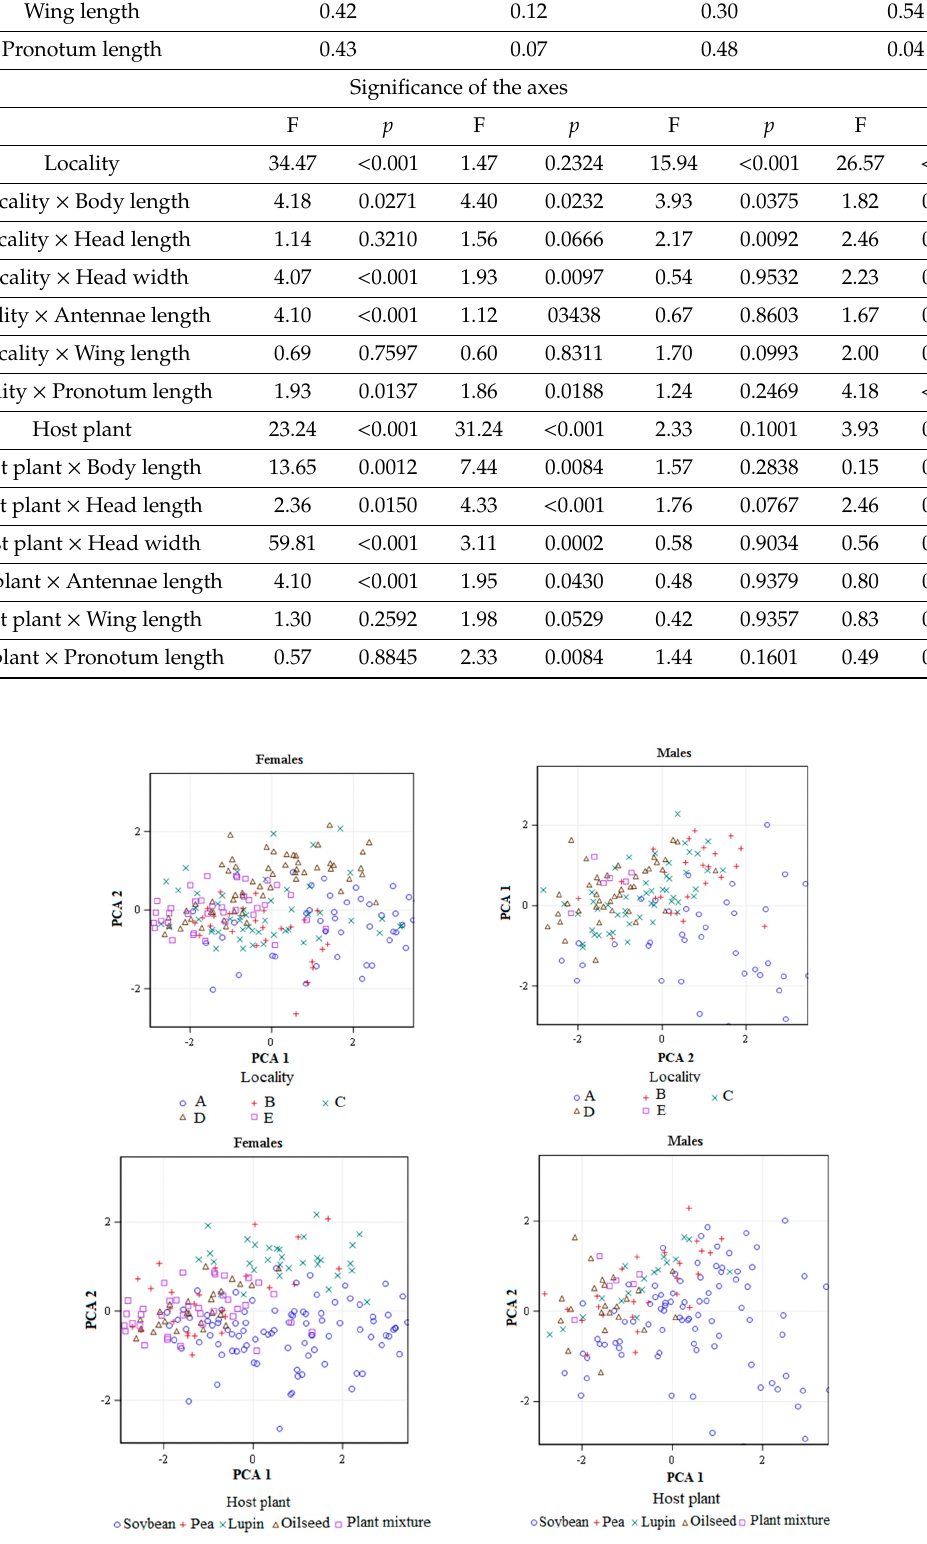
Figure 3. Scatter plots showing clustering of thrips in five localities and five host plants along the first and second principal component axes for males and females of Aeolothrips intermedius.